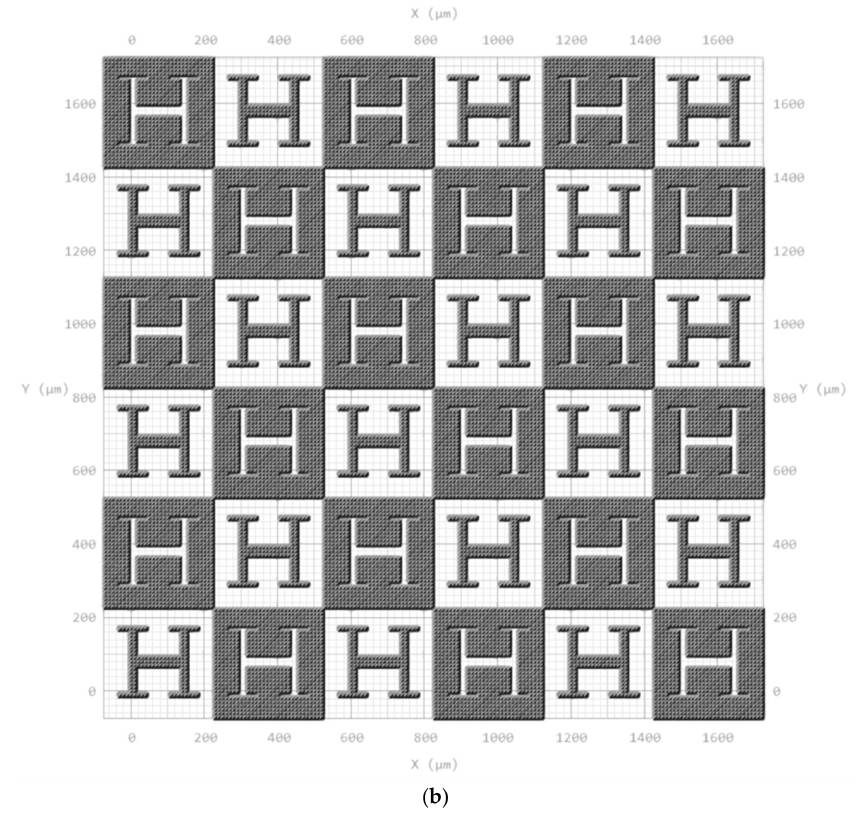
Figure 1. ( a ) Computer-aided design of microstructured surfaces showing both positive and negative alternatives (textured vascular-like region upon a plane and planar vascular-like region surrounded by texture), as well as detailed views of the topographies. ( b ) Design converted into checkerboard-like pattern for higher throughput and more systematic testing ready for direct laser